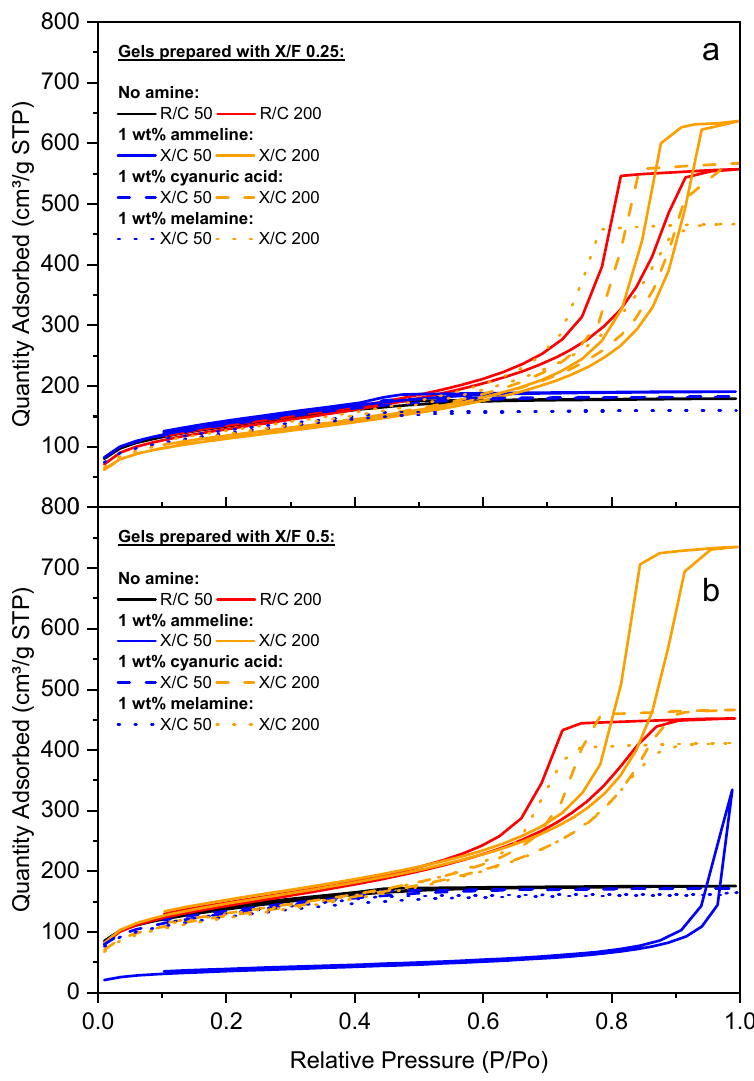
Figure 1. Nitrogen sorption isotherms for gels prepared with 1 wt% of additives and with ( a ) X / F 0.25 and ( b ) X / F 0.5.